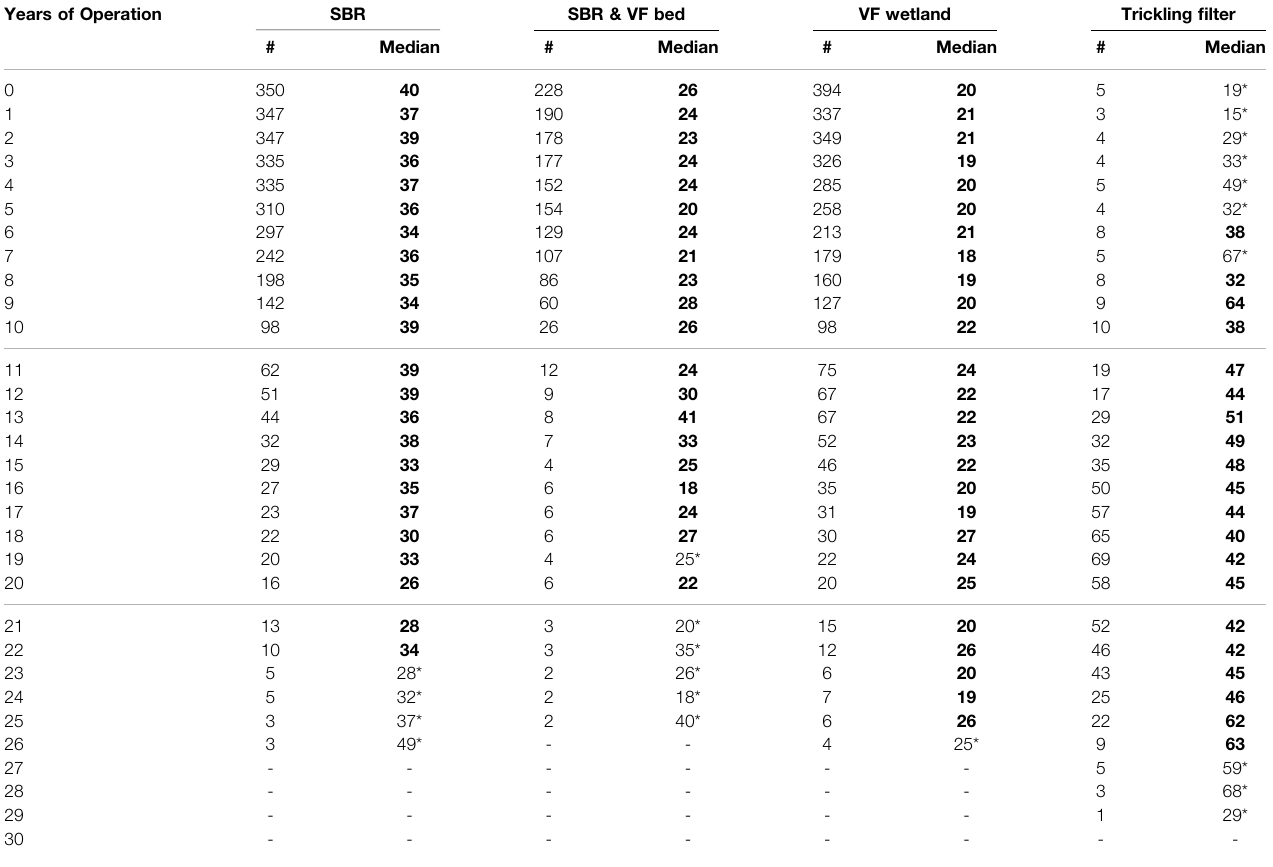
TABLE 5 | Number of data (#) and median value of COD ef fl uent concentration (in mg COD/L) for four technologies depending on the age of the plant (values in bold considered for the following diagrams, * values not considered for the following diagrams as the number of data available was ≤